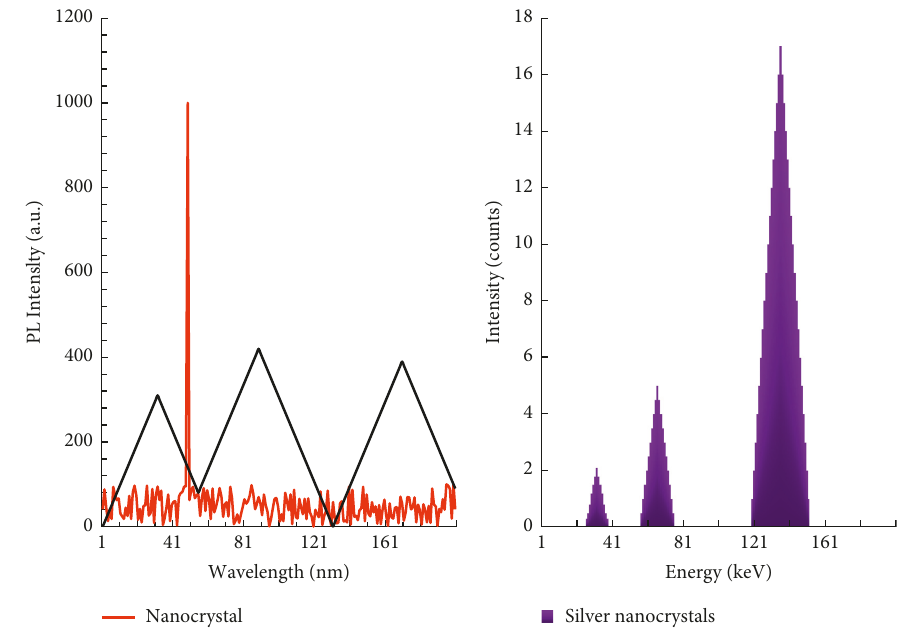
Figure 8: PL characteristics and energy spectra of nanocrystalline and polished silicon